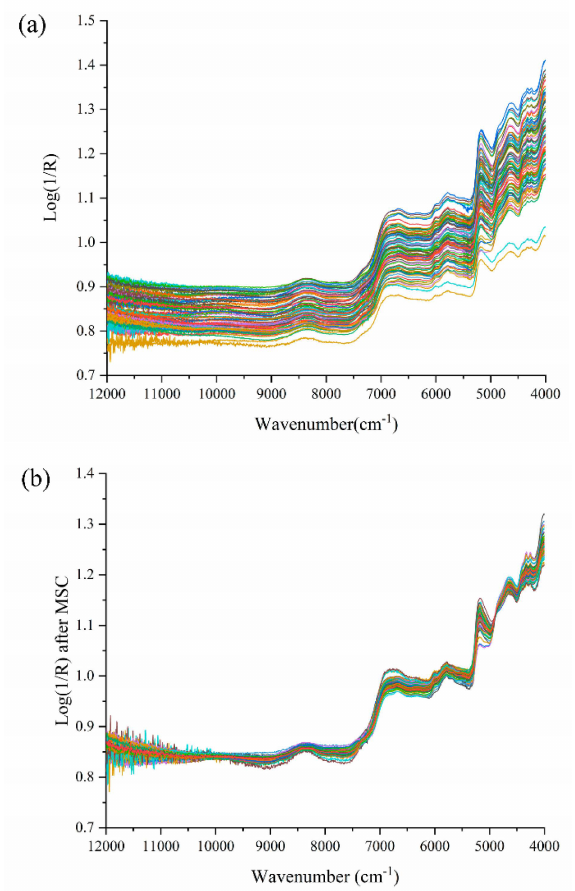
Figure 1. The spectra of all tea samples in the wavenumber range of 12,000–4000 cm − 1 . ( a ) original spectra (log 1/R); ( b ) spectra after pretreatment by multiplicative signal correction